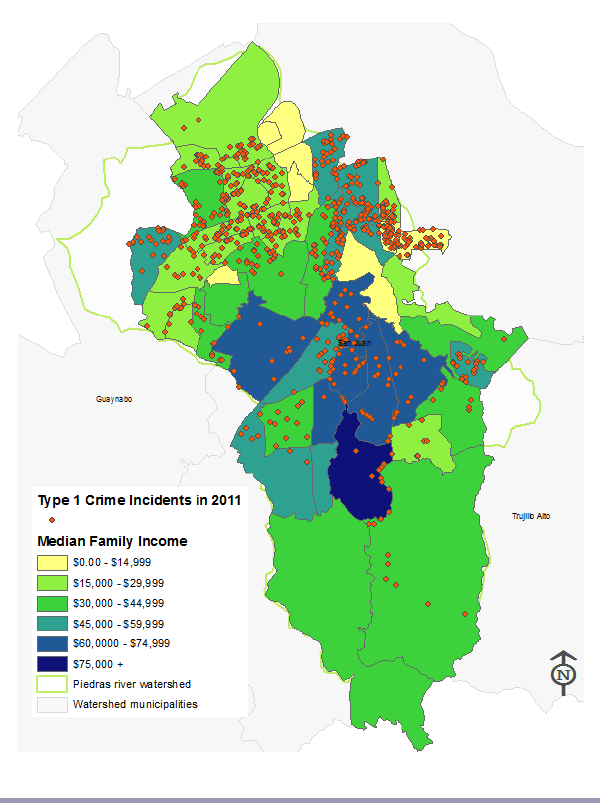
Fig. 2. Location of type I crime incidents by census tract in